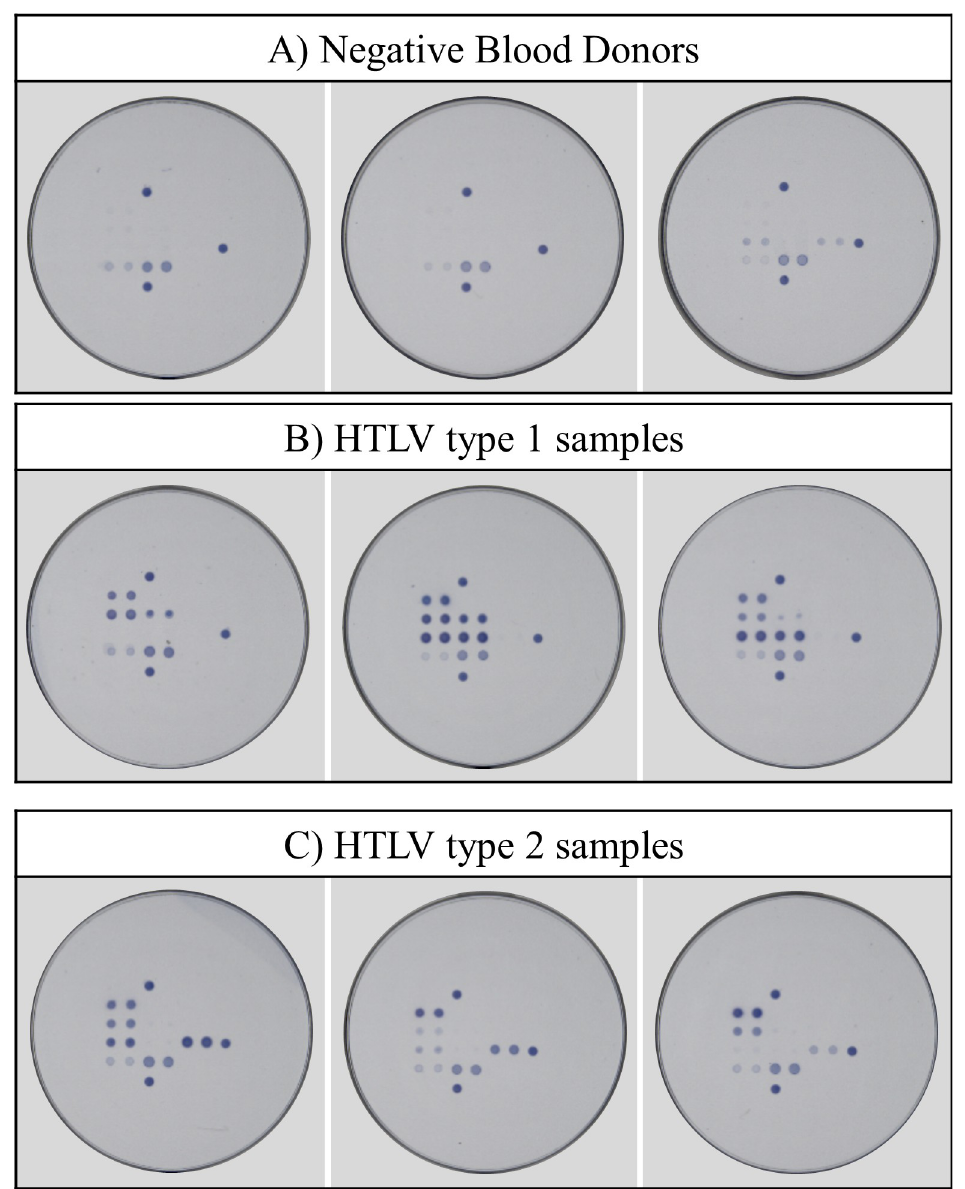
Fig 4. Examples of serological patterns obtained with Multi-HTLV. (A) Examples for three negative blood donors. These are either non-reactive samples or samples that show cross-reactivity with isolated GP46 confirmatory and/or GP46-II typing antigens. (B) Examples for three HTLV-1 patients. Different profiles were observed depending on the individual immune response of each patient. (C) Examples for three HTLV-2 patients. Different profiles were observed depending on the individual immune response of each